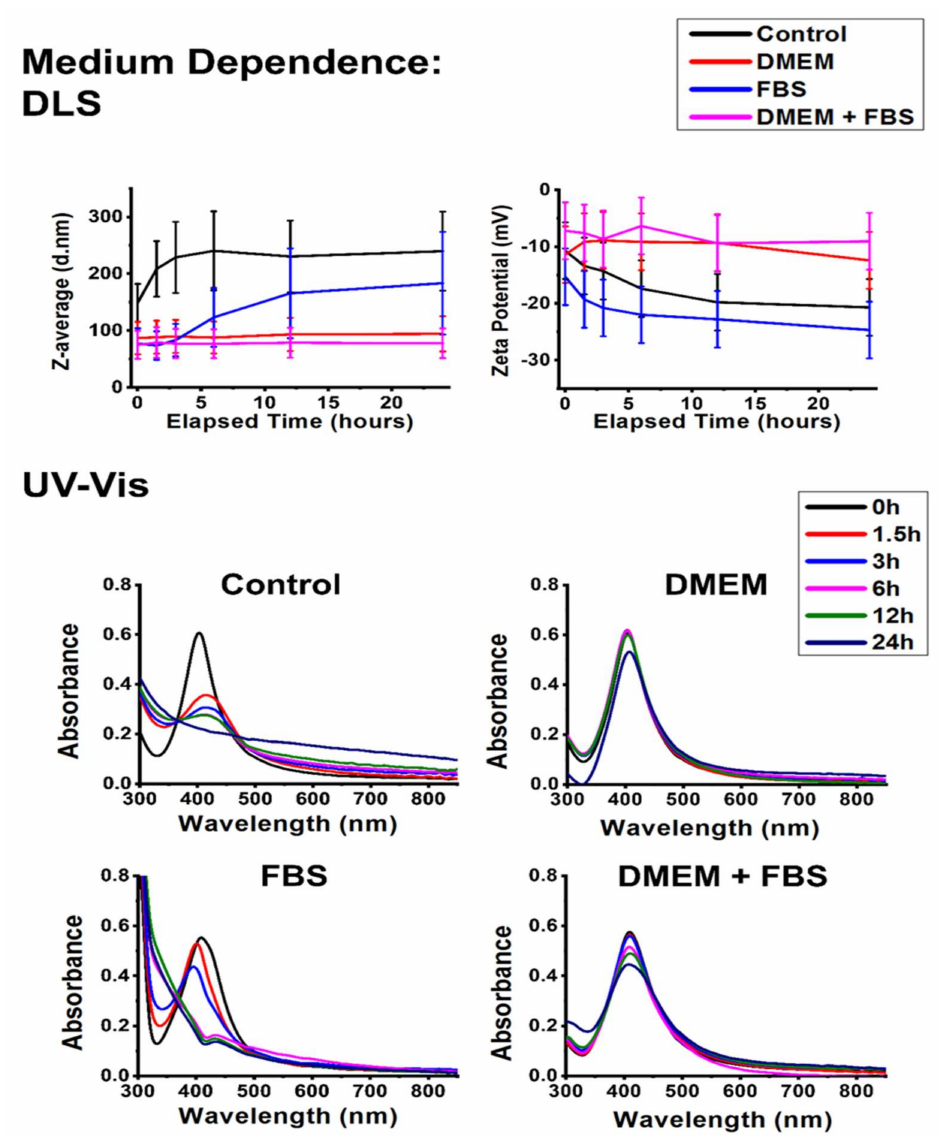
Figure 7. Aggregation behavior of silver nanoparticles characterized by dynamic light scattering (DLS) measurements (top) (average hydrodynamic diameter (Z-average) and zeta potential) and UV–Vis absorbance spectra (bottom) in the presence of cell culture components DMEM and FBS over a 24 h